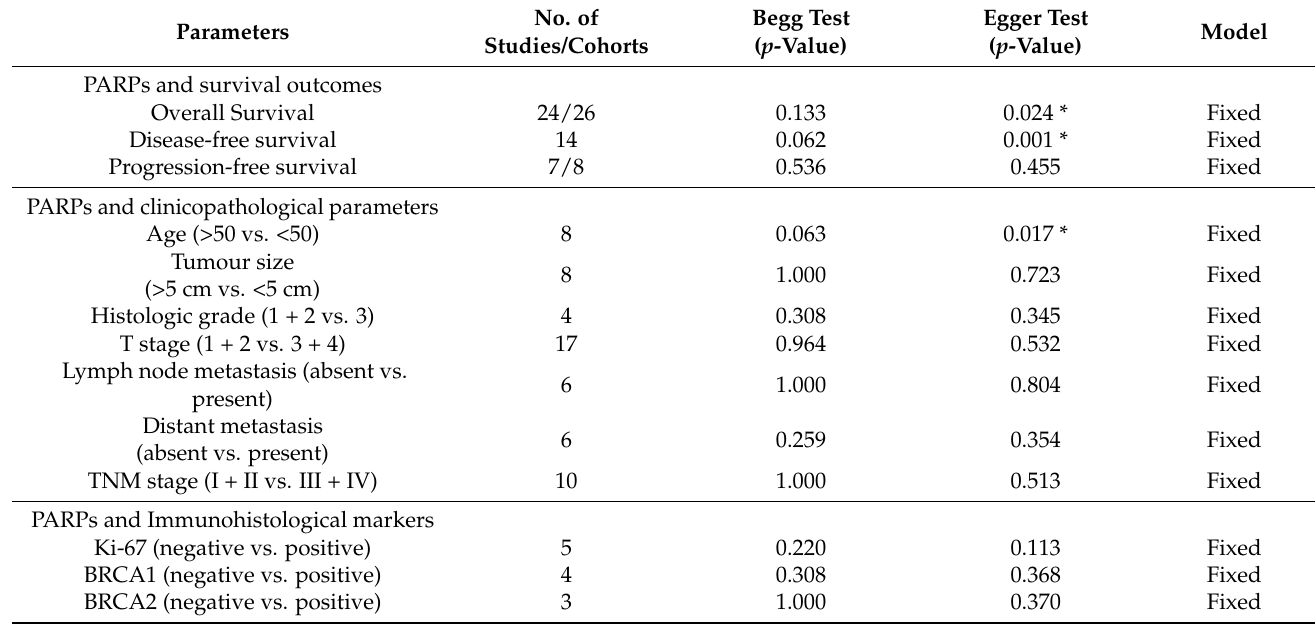
Table 4. The publication bias assessment of the included